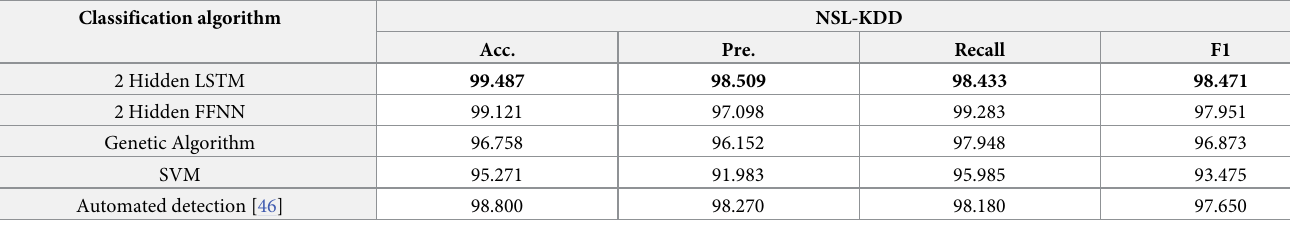
Table 12. SDN Comparison results among different